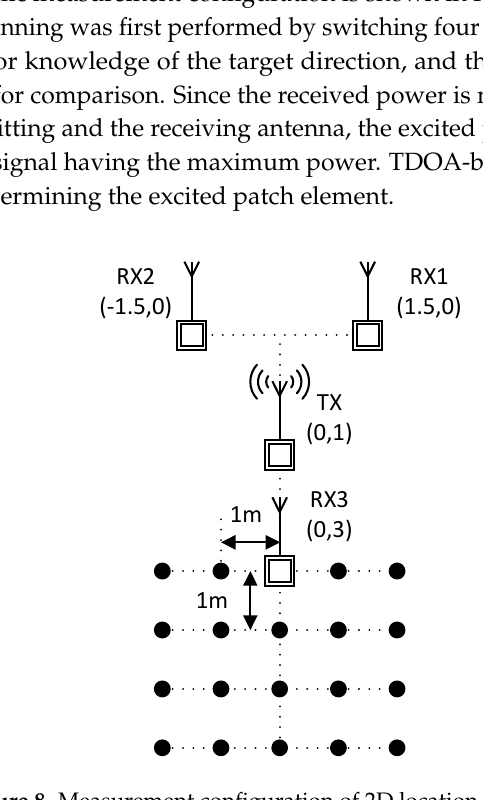
Figure 8. Measurement configuration of 2D location estimation.